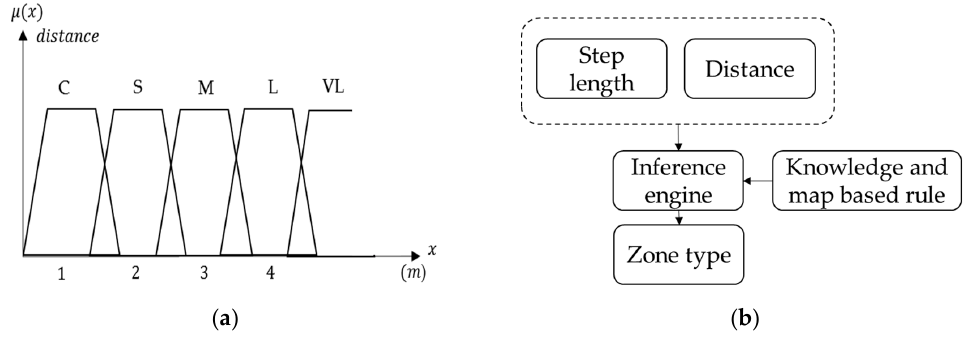
Figure 8. This figure shows the fuzzy system of the next zone type: ( a ) The membership function of minimum distance; ( b ) The fuzzy system of next zone type with the two inputs of fuzzy sets.